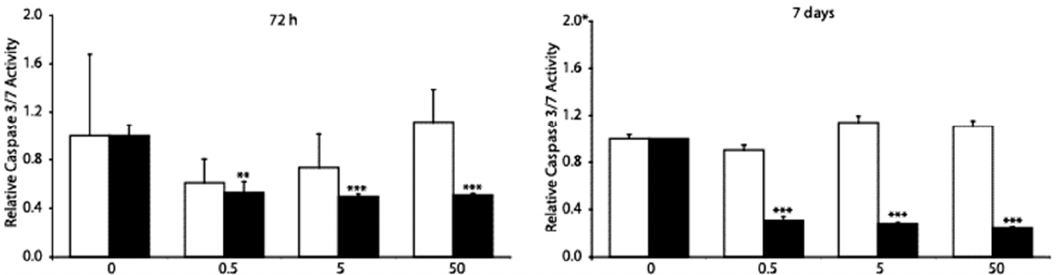
Figure 2. Comparison of the impact of MP and DF on the caspase-3 and caspase-7 activities in MC3T3-E1 pre-osteoblast cells . After 72 h and seven days of treatment with DF (open bars) and MP (black bars), the MC3T3-E1 cells were lysed. The activity of caspase-3 and caspase-7 were determined in triplicate using the Caspase-Glo 3/7 assay (Promega Corporation, Madison, WI, USA), as described in the Materials and Methods section. Results were the mean ± SD of four separate experiments, the untreated control assuming that the caspase activity of the control cells equals 1. The significance was evaluated using one-way ANOVA with Tukey’s post hoc test. The significance level was set at 5% (* p < 0.05); significant at: ** p < 0.01, and *** p < 0.001.